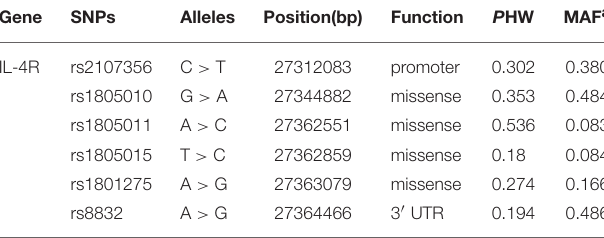
TABLE 1 | General characteristic of SNPs in IL-4R